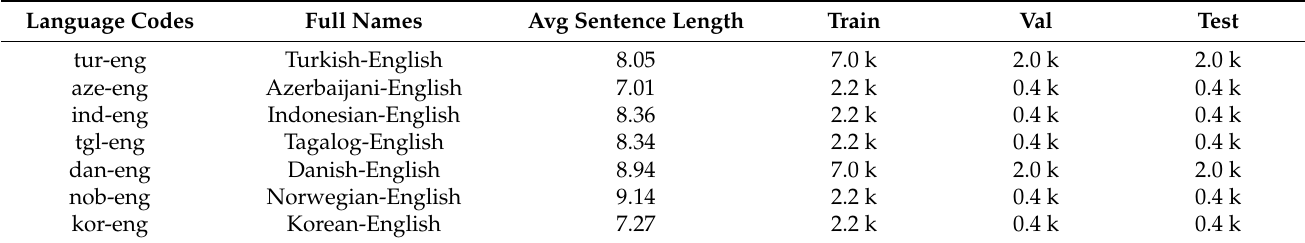
Table 1. Attributions of Translation Corpora.